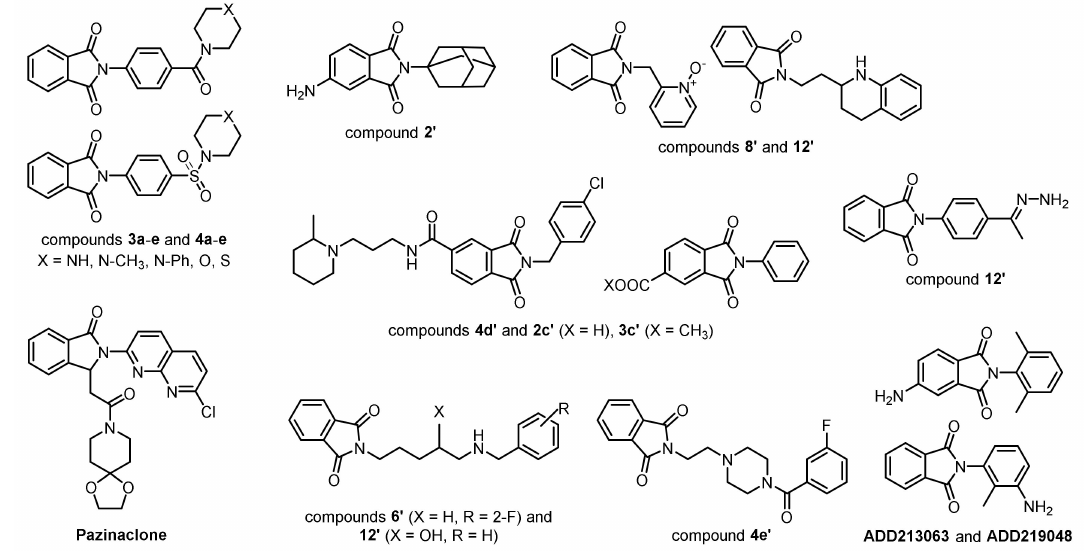
Figure 1. Examples of phthalimide derivatives with various biological activity